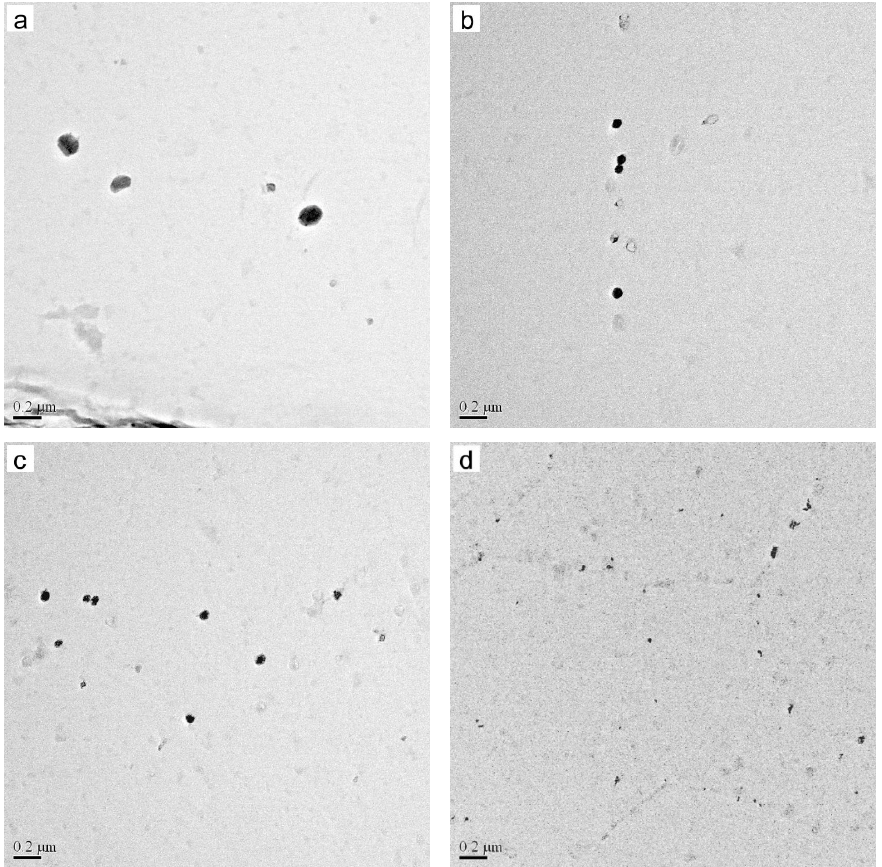
Figure 2. Typical distribution of precipitates in four samples: ( a ) Nb-free, ( b ) Nb-0.005 wt%, ( c ) Nb- 0.009 wt% and ( d ) Nb-0.025 wt%.